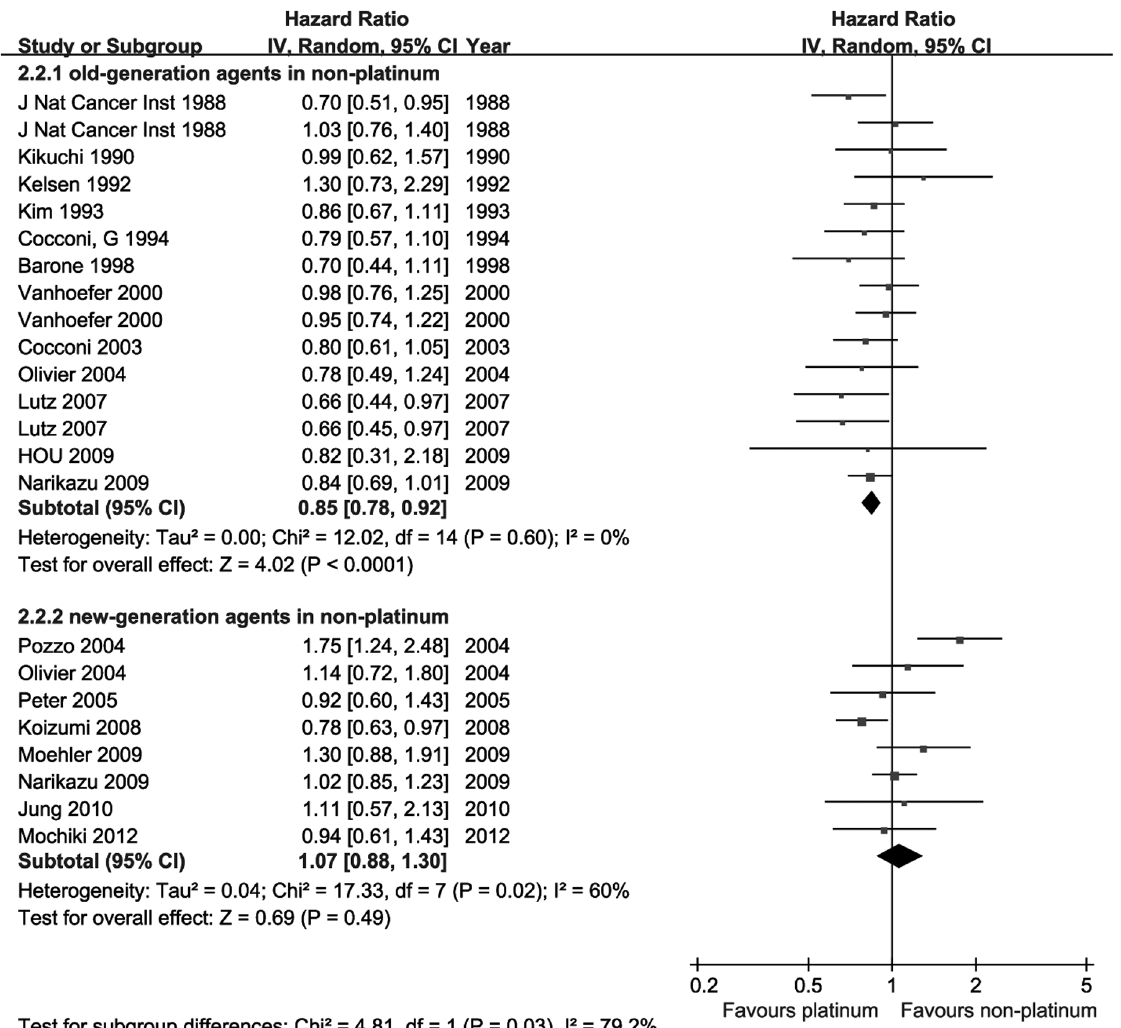
Figure 3. Comparison of overall survival between platinum-based therapy and nonplatinum-based therapy. Subgroups were stratified according to whether the non-platinum contained new-generation agents such as S-1, taxanes or irinotecan.